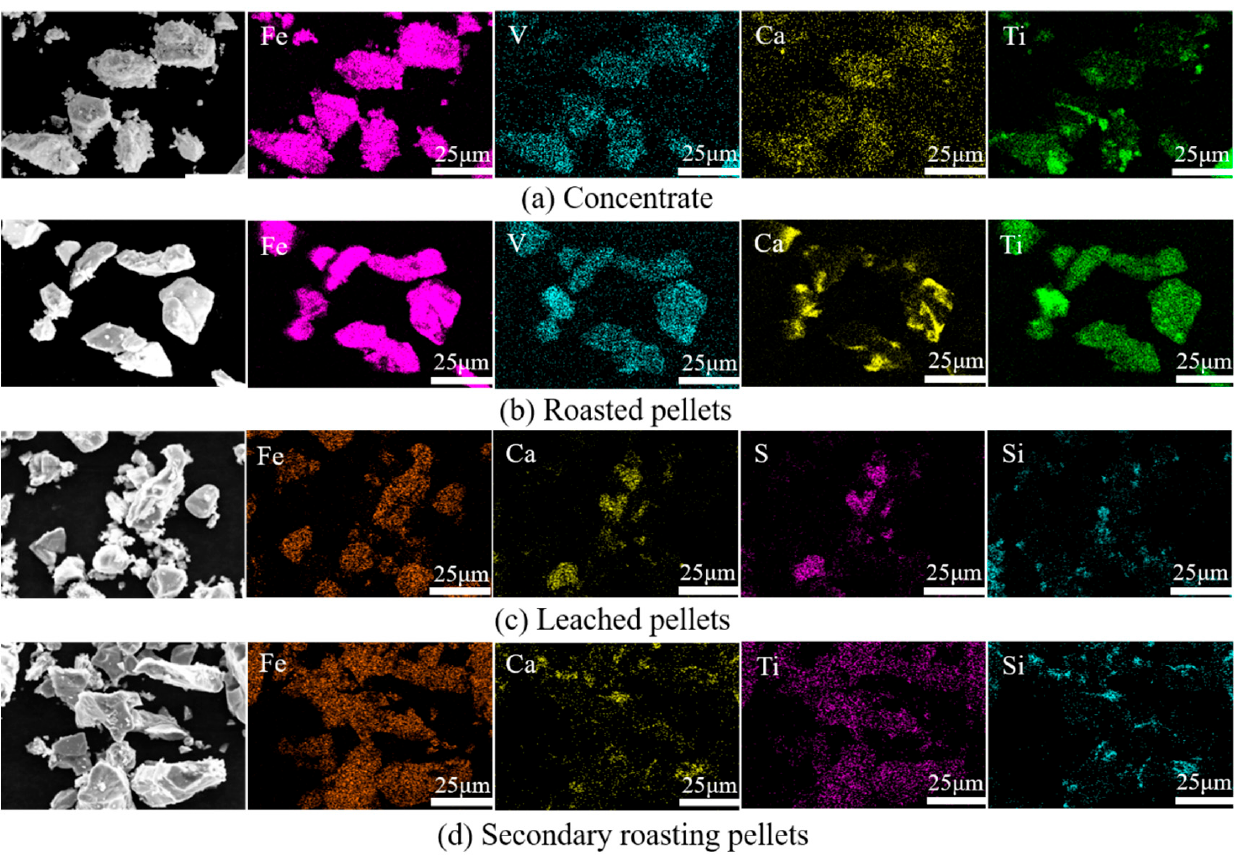
Figure 8. SEM images with EDS element mappings of iron ore concentrates at different stages. ( a ) EM-EDS analysis of concentrate; ( b ) EM-EDS analysis of roasted pellets; ( c ) EM-EDS analysis of leached pellets; ( d ) SEM-EDS analysis of secondary roasted pellets.